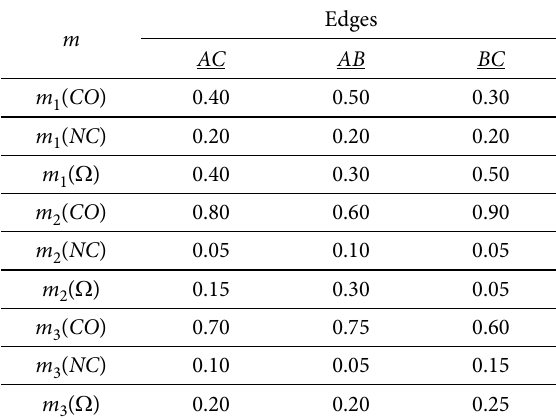
Table 1. BBA functions for 3 edges